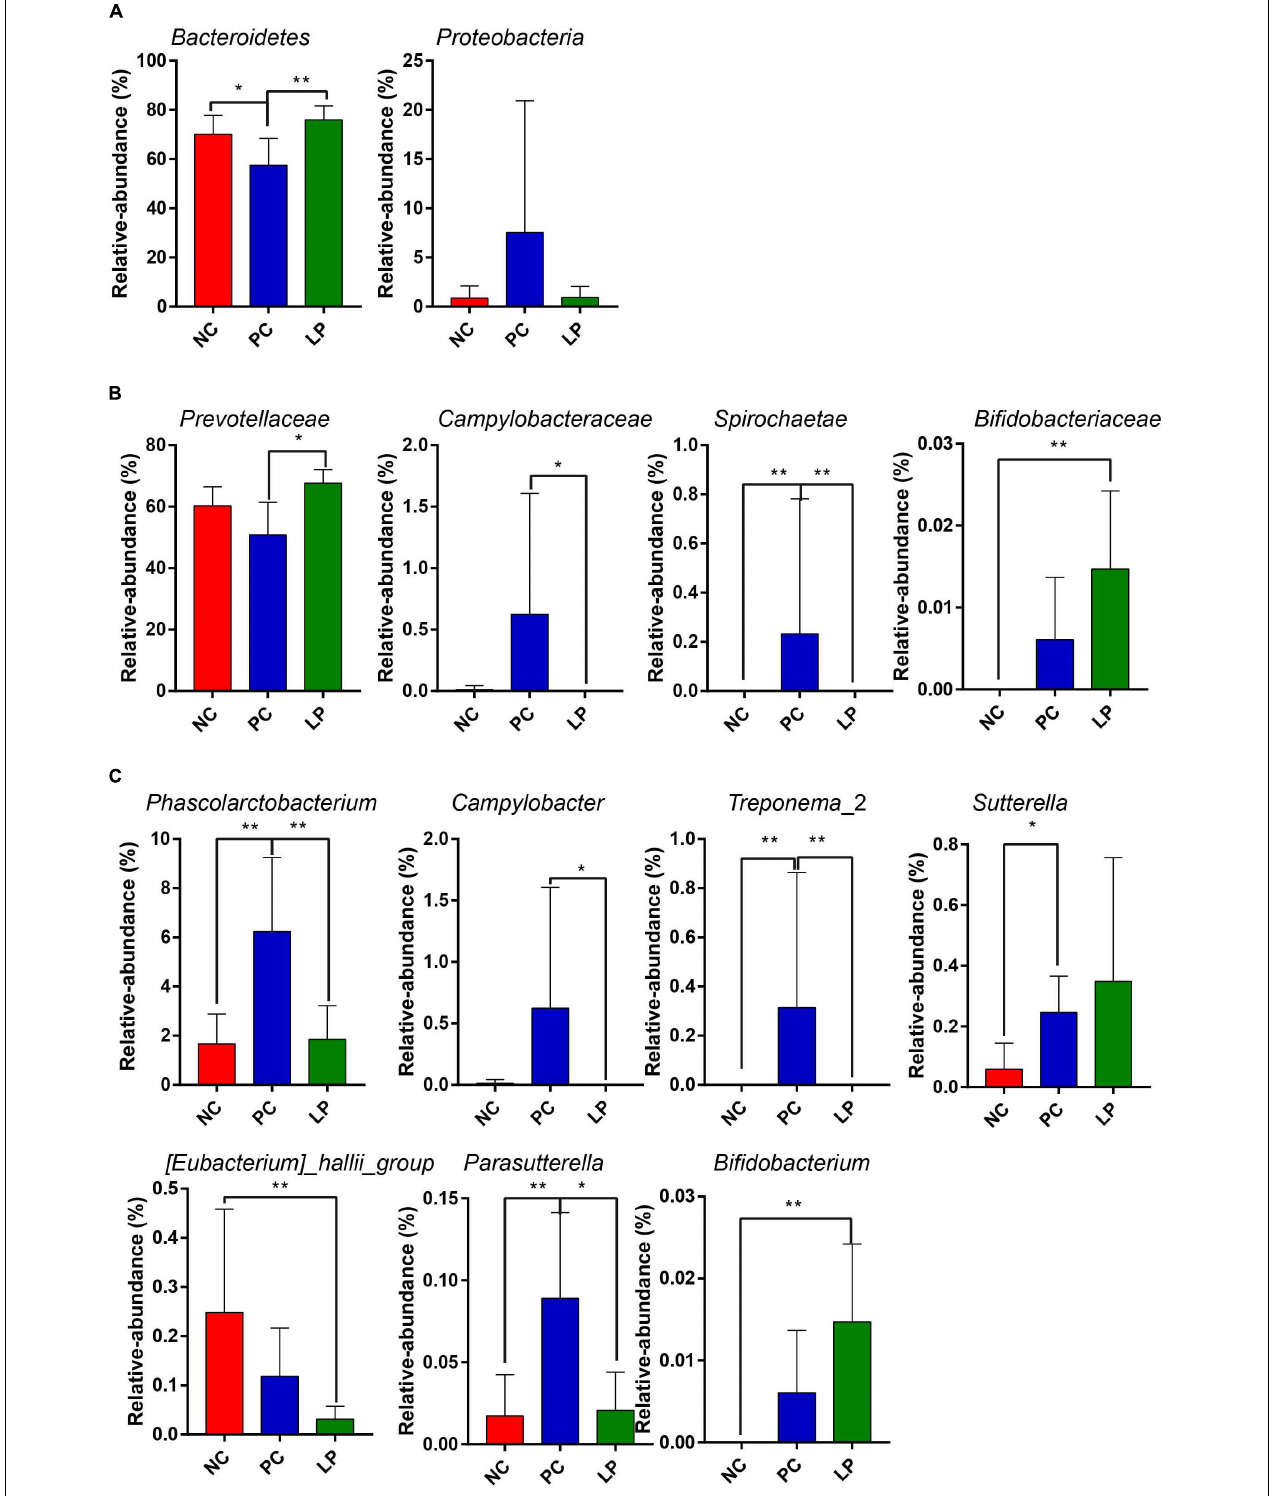
FIGURE 2 | Comparison of the colonic microbial community in weaning piglets from NC, PC, and LP groups. Differences in microbial community at the (A) phylum level, (B) family level, and (C) genus level. Values are expressed as mean ± SD. ∗ P < 0.05, ∗∗ P < 0.01.